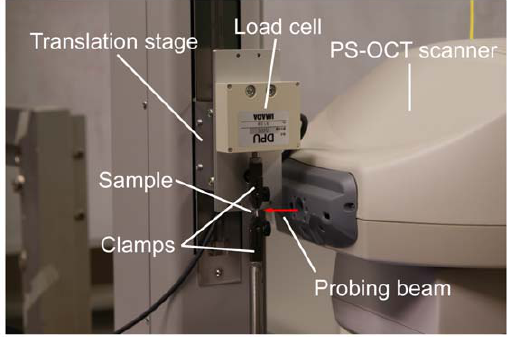
Figure 2. The experimental system for birefringence and elasticity